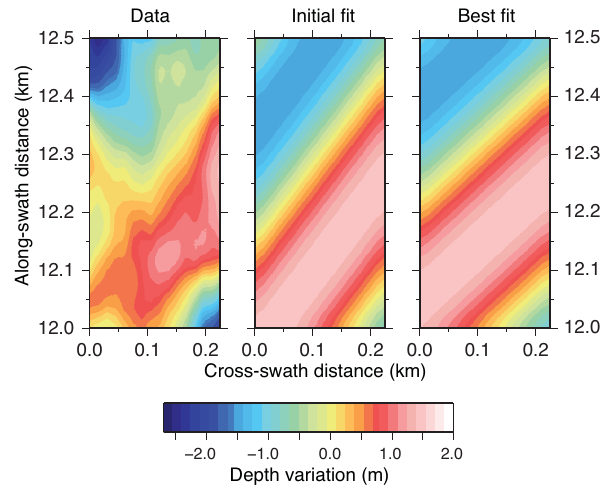
Fig. 8. A second way of determining reflection peak/trough orien- tation is to fit a sinusoidal surface to the reflection data. The data (same portion of reflection 2 as shown in Fig. 7) is plotted on the left. In the center is a sinusoidal surface fit obtained by adjusting surface parameters by hand until a fit is obtained that looks good to the eye. This gives an orientation angle of 37 ◦ (corresponding to an azimuth of 171 ◦ ), wavelength of 0.45km and phase shift of 0.25 times the phase length, where the orientation angle is defined as in Fig. 7. On the right is the “best” fit (fit with minimum error). This surface has an orientation angle of 47 ◦ (corresponding to an azimuth of 181 ◦ ), wavelength of 0.505km, and phase shift of 0.7 times the phase